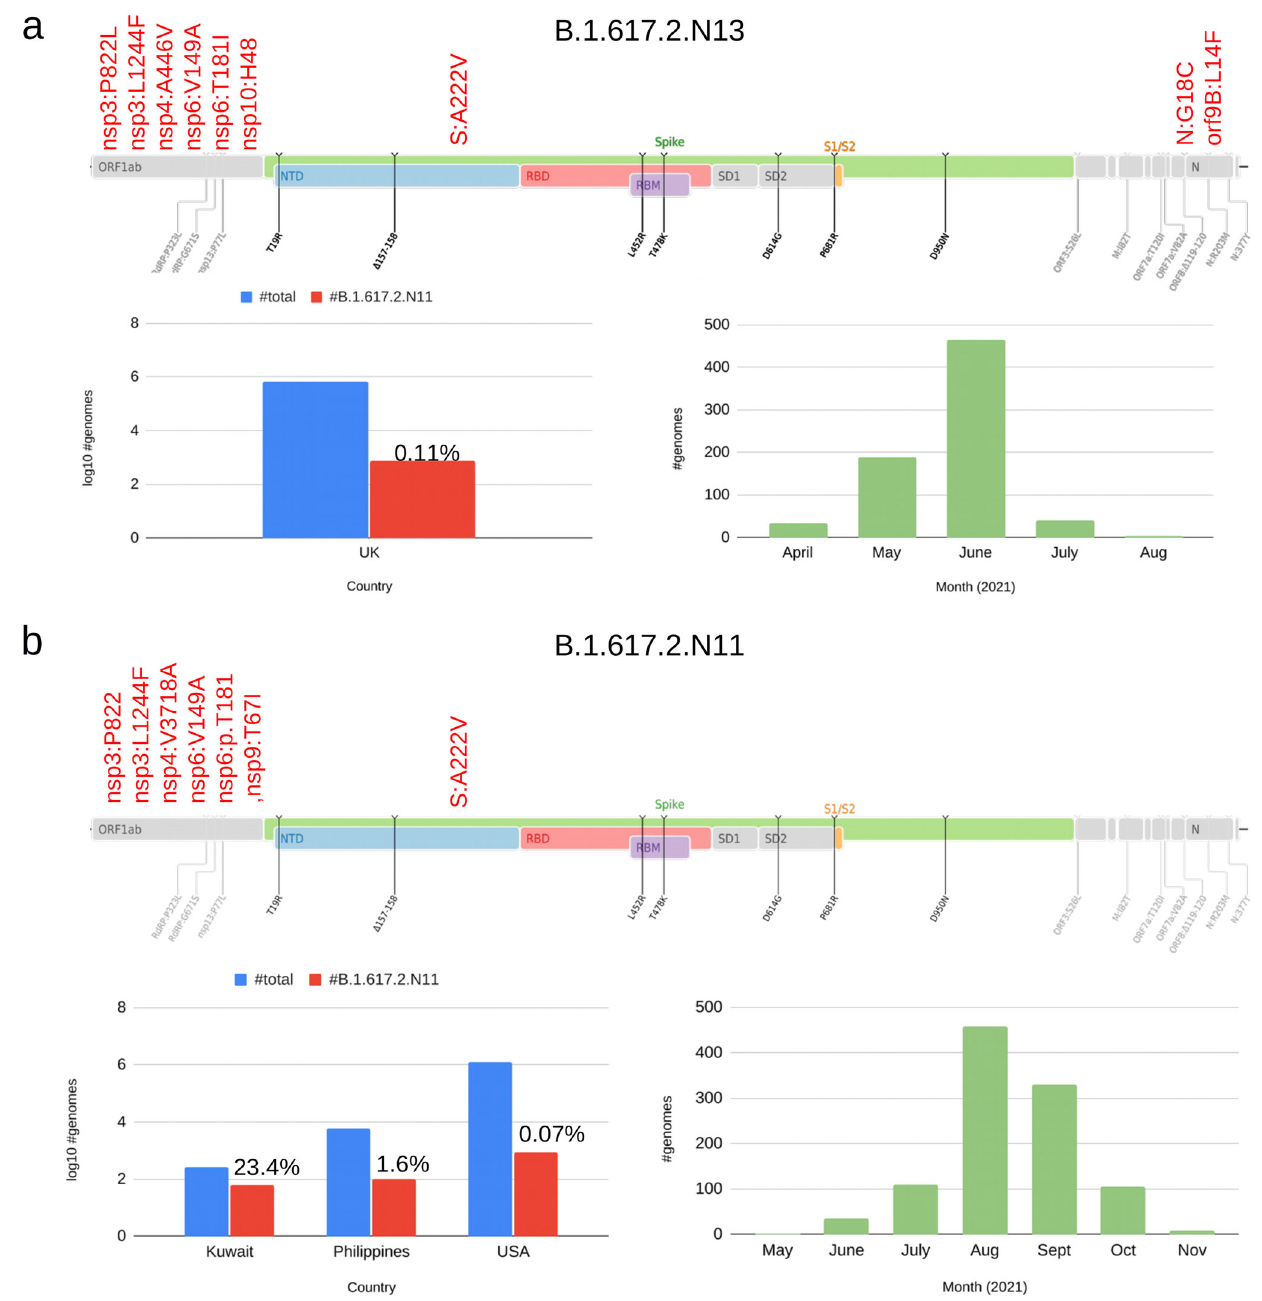
Fig. 6 Interesting Pango + lineages derivative of Delta VOC. a De fi ning genomic variants and prevalence of the B.1.617.2.N13 Pango + lineage. Red: novel genomic variants speci fi c to the Pango + lineage; black: genomic variants characteristic of Delta in the Spike glycoprotein (S); gray: genomic variants characteristic of Delta outside the S gene. Barplots represent the total number of sequences and estimated prevalence of B.1.617.2.N13 in countries from which more than 50 genome sequences were recovered (log10 scale) and total number of genome sequences assigned to B.1.617.2.N13 from April 2021 to August 2021. b De fi ning genomic variants and prevalence of B.1.617.2.N11 Pango + lineage. Red: novel genomic variants speci fi c to the Pango + lineage; black: genomic variants characteristic of Delta in the Spike glycoprotein (S); gray: genomic variants characteristic of Delta outside the S gene. Barplots represent the total number of sequences and estimated prevalence of B.1.617.2.N13 in countries from which more than 50 genome sequences were recovered (log10 scale) and total number of genome sequences assigned to B.1.617.2.N13 from May 2021 to November 2021. Annotation of protein-coding genes and protein domain according to the Uniprot annotation (UP000464024) of the reference SARS-CoV-2 genome (NC_045512). The source data behind this fi gure is reported in Supplementary Data